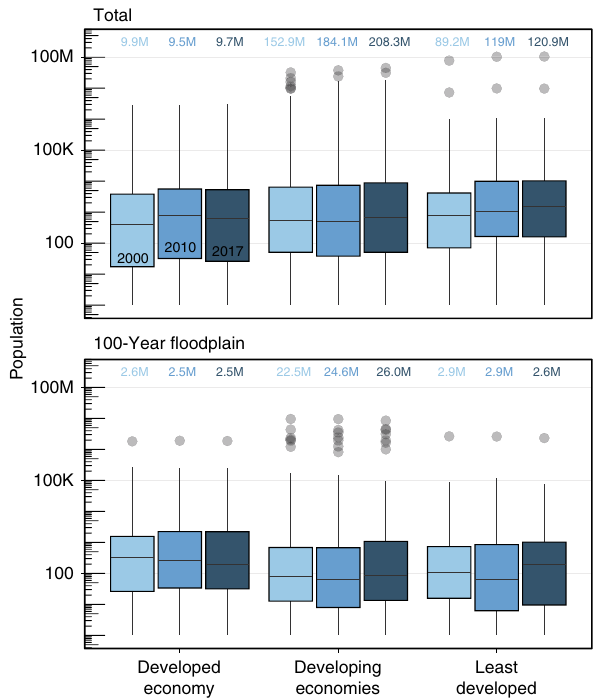
Fig. 3 Population distribution for deltas classi fi ed according to United Nations development categories for their respective countries. The box and whisker plots show the distribution for all deltas with a given economic development category for each year. The median value is the horizonal line in the box, box width corresponds to the upper and lower quartiles. The whisker lengths represent the lower and upper 25% quartile distribution of all deltas within a category, and gray dots are outliers. Colored numbers refer to the total in each